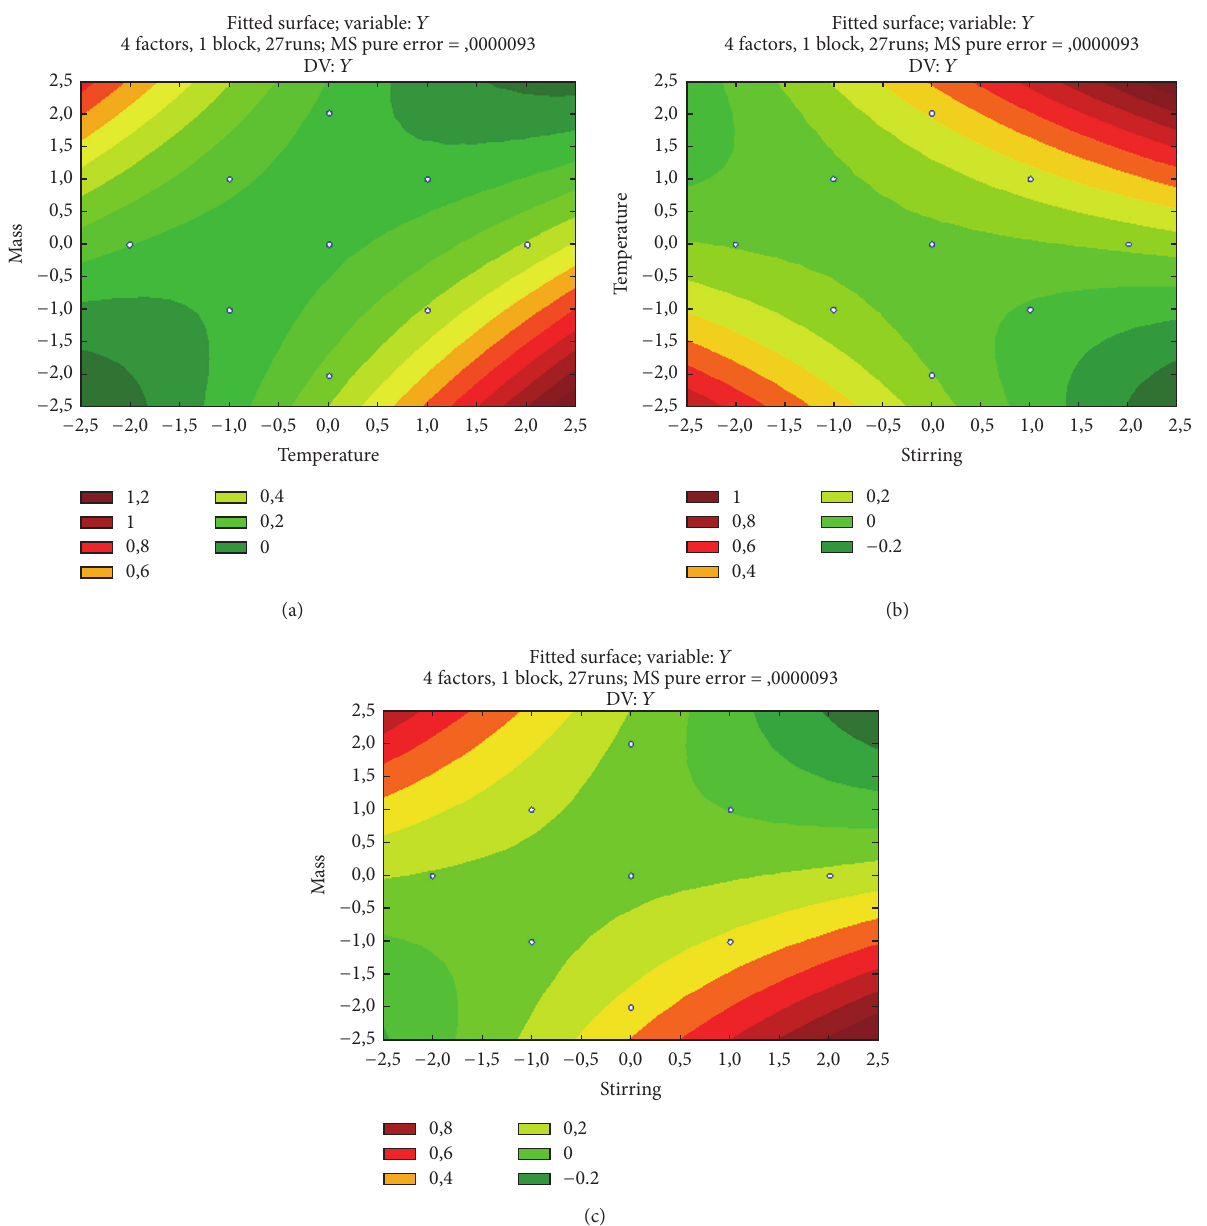
Figure 2: Response surface obtained by the CCRD mathematical model design for the extraction of resveratrol by the microwave-assisted method as a function of (a) temperature and mass; (b) temperature and stirring; and (c) stirring and mass.